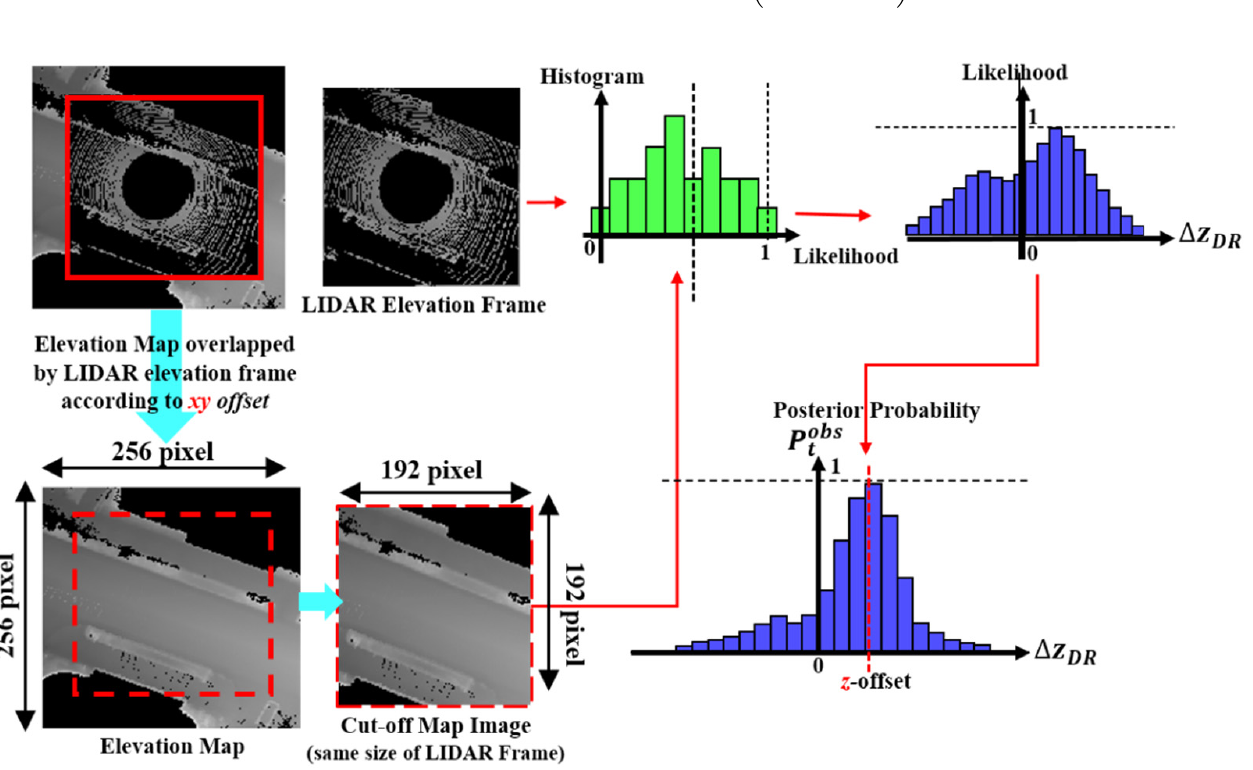
Figure 7. LSM based localization system in the Z plane. Elevation map image is cut off in the same size of LIDAR elevation frame (192 × 192) according to the obtained offsets in XY plane. Histogram between the elevation LIDAR and cut-map images is created and converted into a likelihood vector and then skinned by Sigmoid function to estimate z-offset based on Otsu’s threshold.